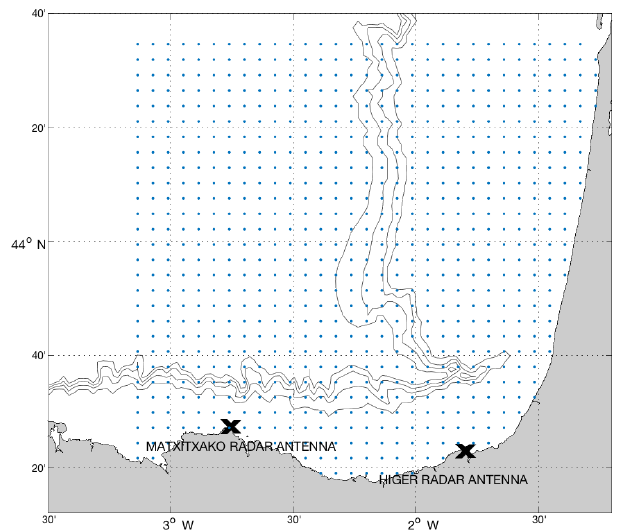
Figure 1. Map showing the location of the two antennas (Matxitx- ako and Higer) of the BoB HFR systems. The grid points of the total HFR velocity field are plotted in